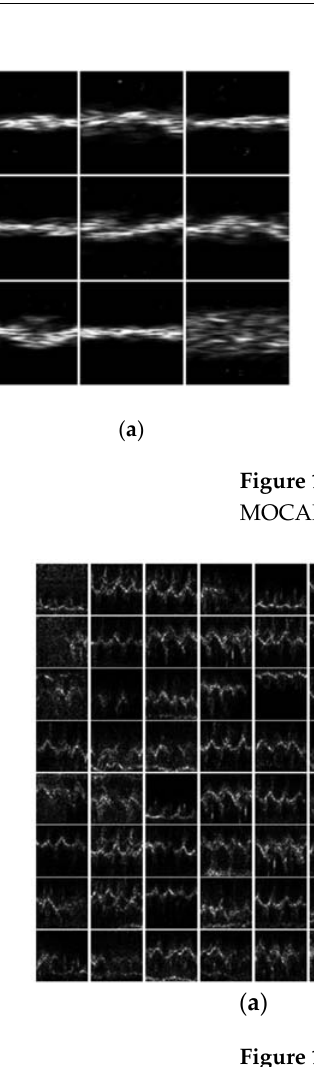
Figure 9. Generated samples of the pedestrian database obtained using the modified Boulic model.